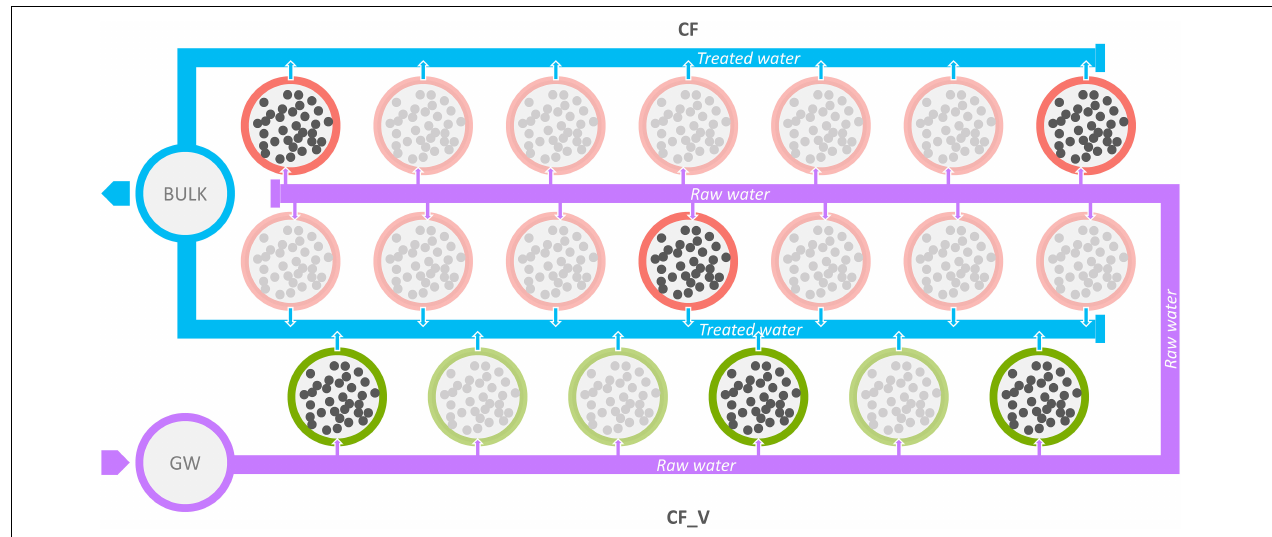
FIGURE 1 | Schematic representation of the sampling points examined. Violet circle: inlet water from groundwater (GW); red circles: mineral GACs (CF); green circles: vegetal GACs (CF_V); light blue circles: bulk water collected from GACs, both vegetal and mineral (BULK); blurred circles indicate not sampled GACs. Raw water flux from groundwater is represented in violet, while the treated (after the passage through GAC filters) water flux is represented in light blue.